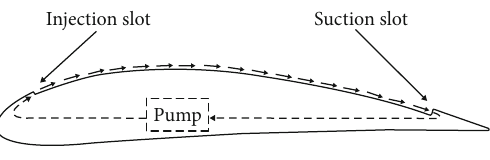
Figure 2: Co fl ow jet